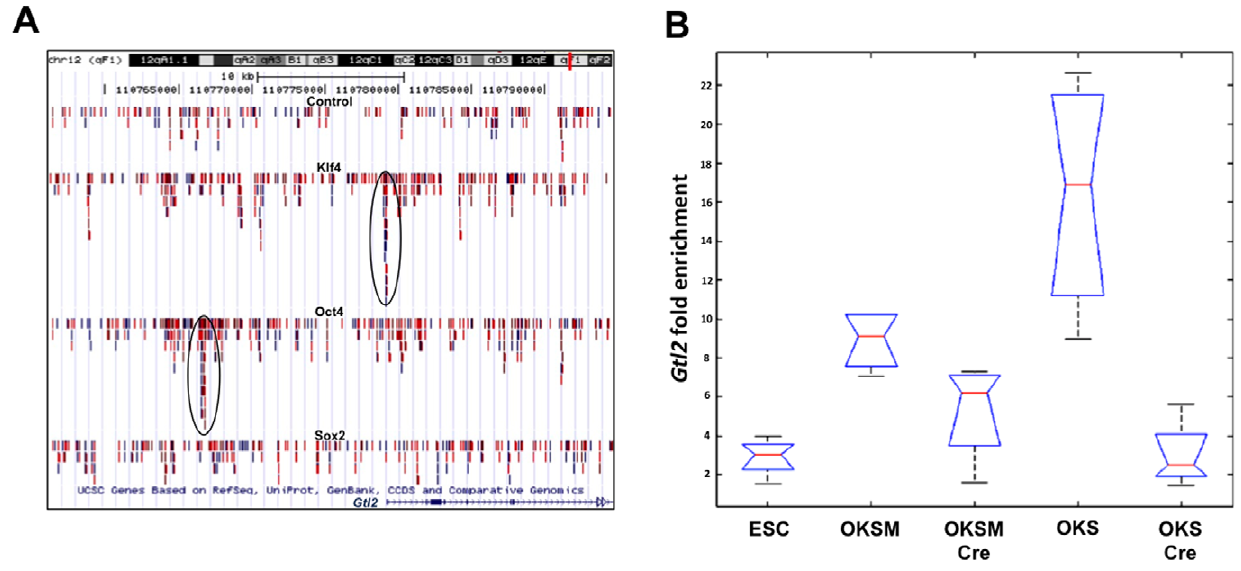
Figure 3. Klf4 is recruited to the Gtl2 promoter region during reprogramming to pluripotency. (A) Putative binding sites for the Yamanaka factors were identified in the Gtl2 promoter region using ChIP-seq data. (B) ChIP-qPCR analysis confirmed increased binding of Klf4 to the Gtl2 imprinted domain in transgene-carrying iPSCs. Cross-linked protein-DNA complexes were immunoprecipitated from whole cell extracts of ESC/ iPSCs using an anti-Klf4 or a control antibody and DNA within the precipitates was isolated and amplified using primers specific for the Gtl2 promoter. Results are shown as fold-enrichment relative to the control antibody.